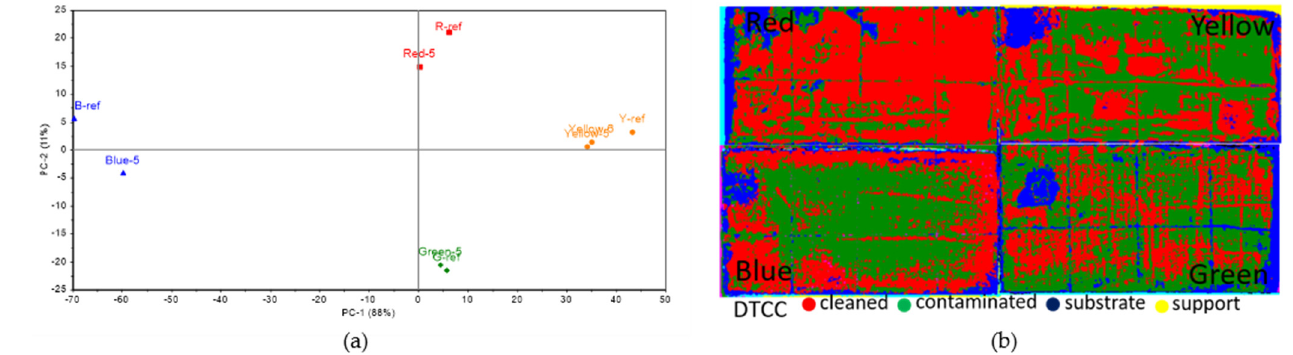
Figure 9 . Colorimetric and hyperspectral evaluation of TDC decomposition by fungal lipase. (a ) Score plot of the first 2 PCs, based on colorimetry data; ( b ) SAM images based on hyperspectral